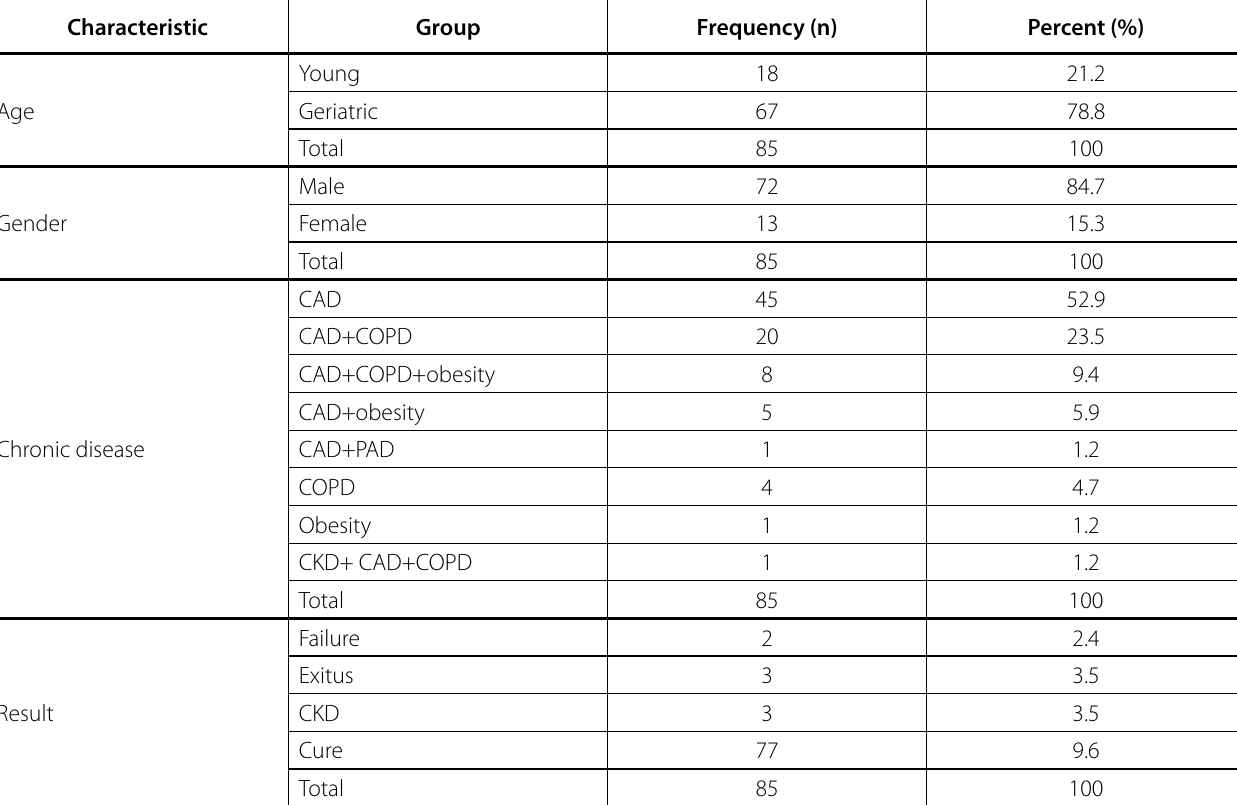
Table 1 . Patients’ descriptive